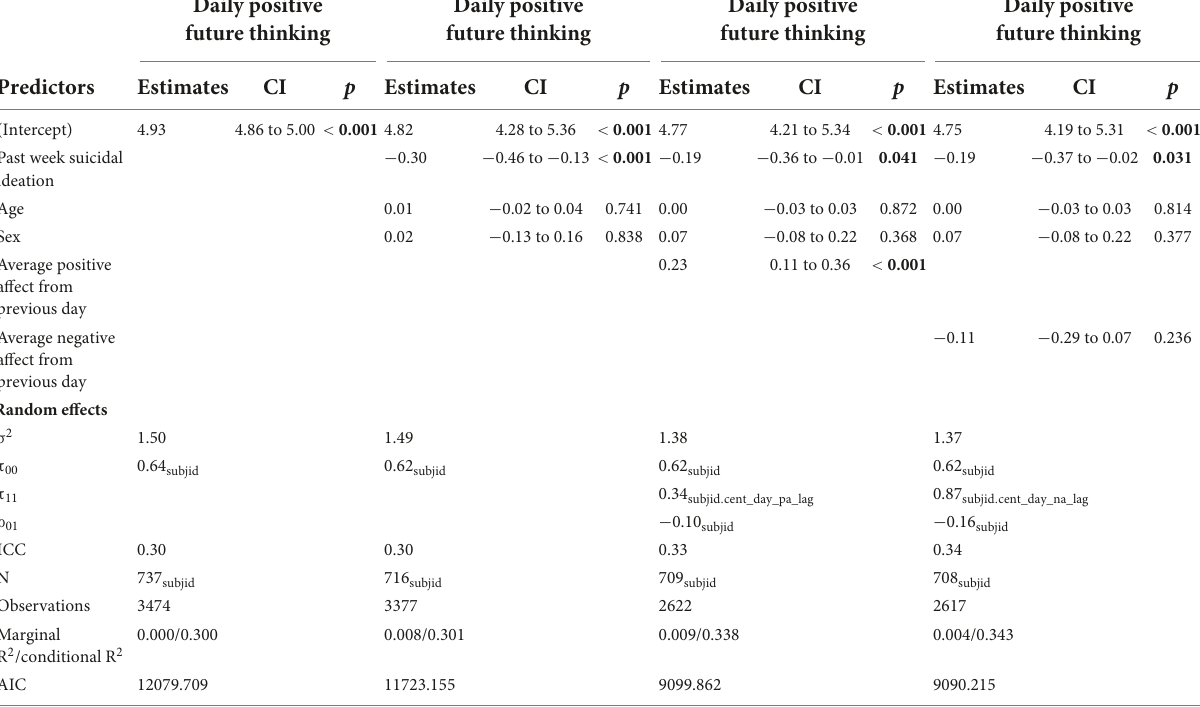
TABLE 3 Multilevel model